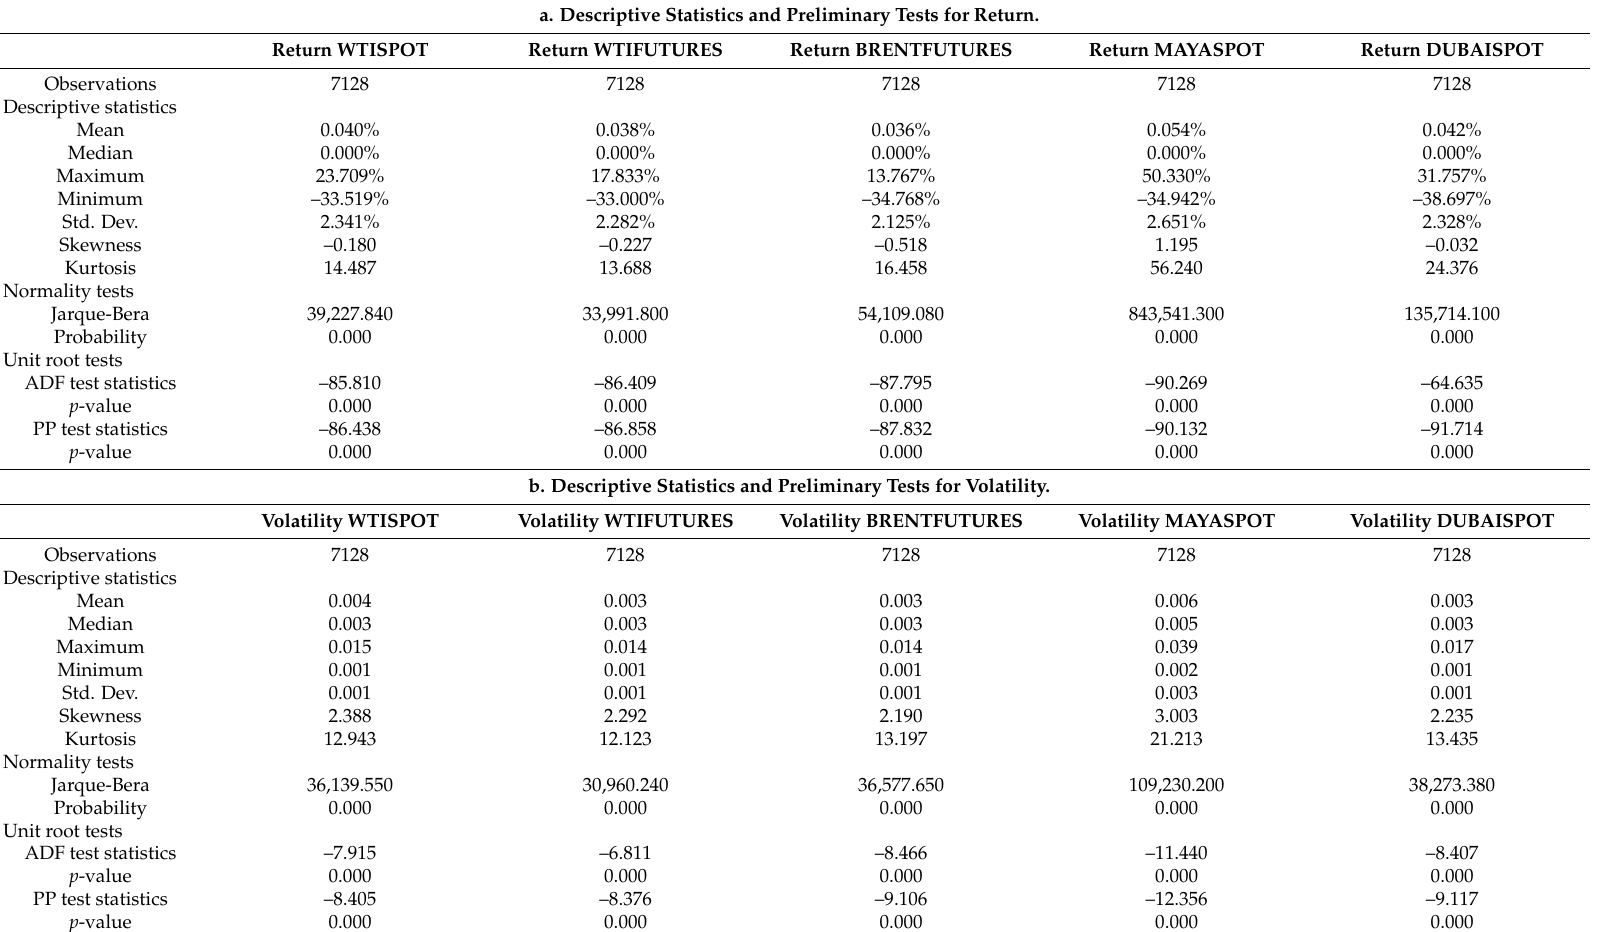
Table 2. Descriptive statistics and preliminary tests for return and